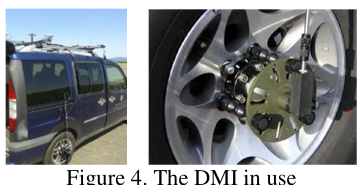
Figure 3. Instruments on board